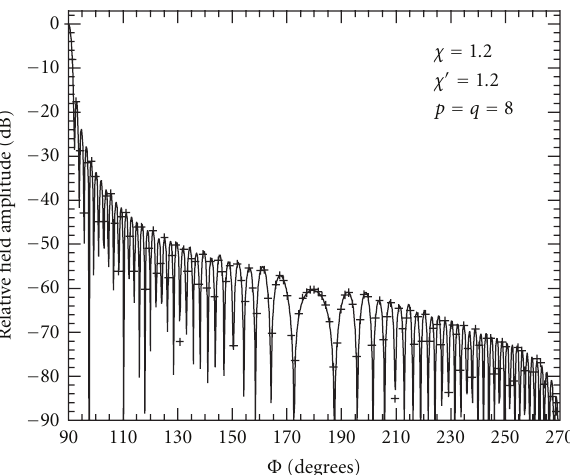
Figure 9: H-plane pattern. Solid line: exact. Crosses: recovered from the irregularly spaced helicoidal NF